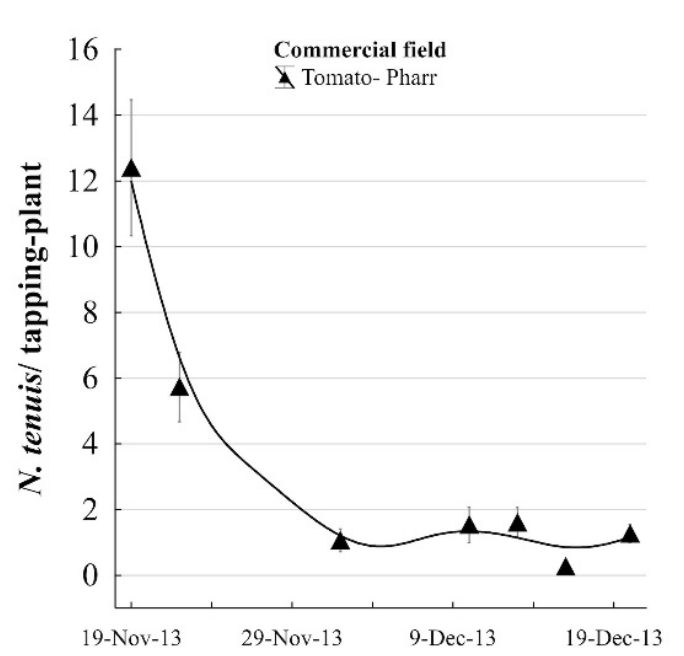
Figure 4. Mean ( ± SE) population of Nesidiocoris tenuis on tomato plants in a commercial field Figure 4. Mean (±SE) population of Nesidiocoris tenuis on tomato plants in a commercial field located located at Pharr, Hidalgo Co. TX, USA. The moving mean curves shown with lines were fitted by a distance-weighted least squares at Pharr, Hidalgo Co. Texas. The moving mean curves shown with lines were fitted by a distance- weighted least squares method.